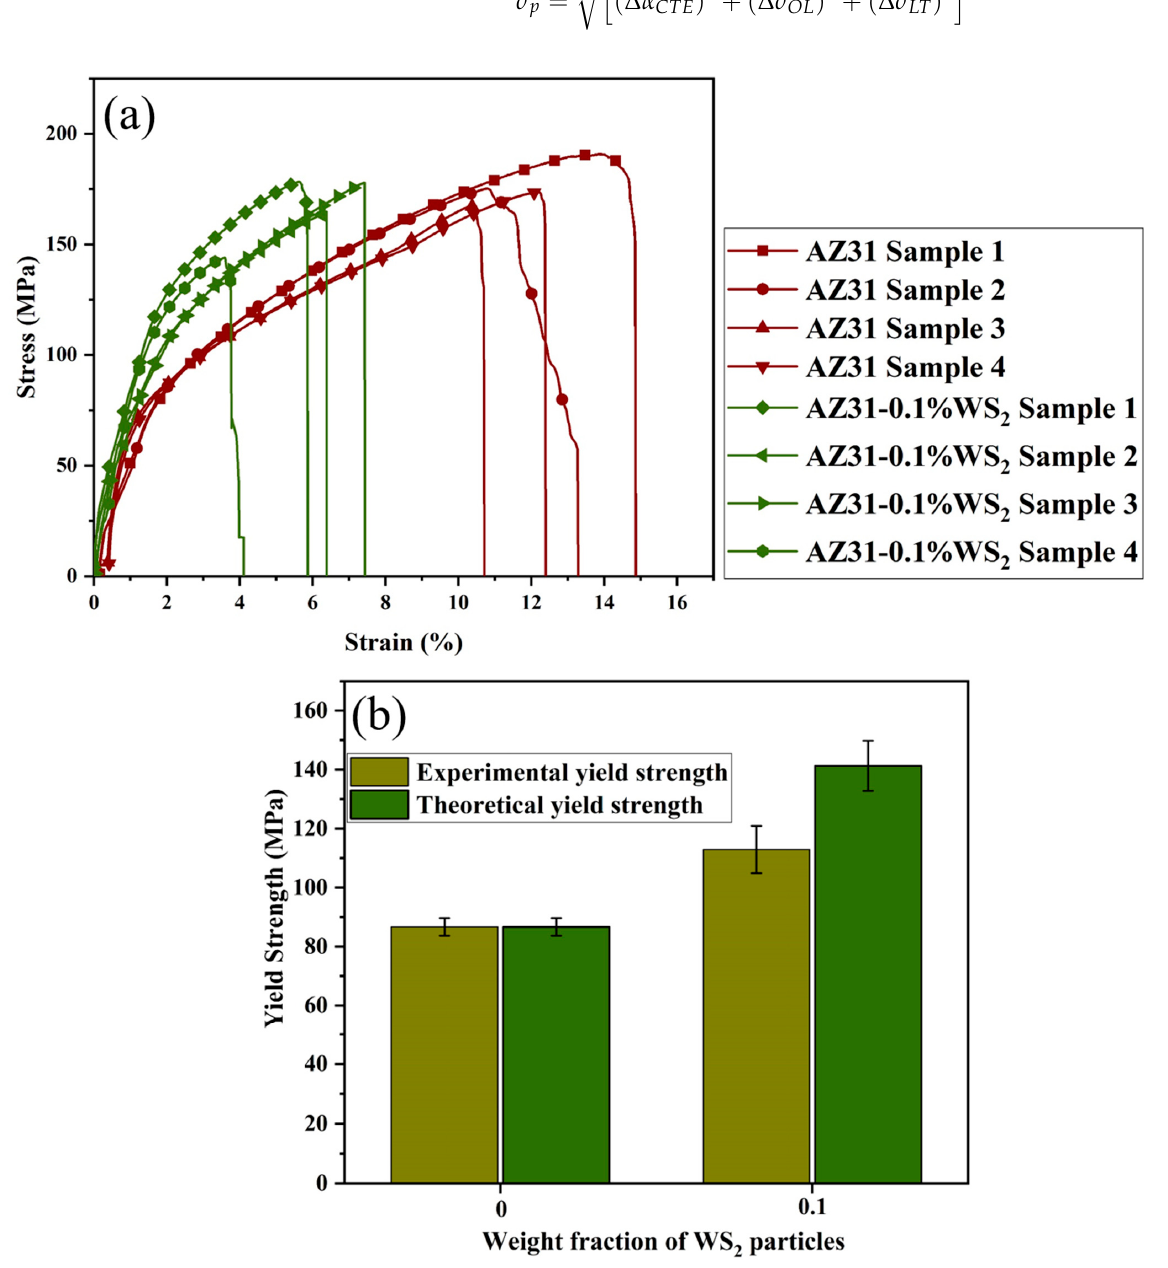
Figure 3. ( a ) Stress – strain curve and ( b ) experimental and theoretical values of the fabricated nanocomposites.